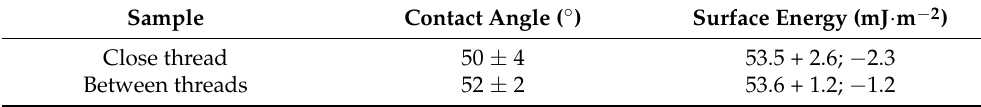
Table 3. Value of measured contact angle and calculated surface energy .